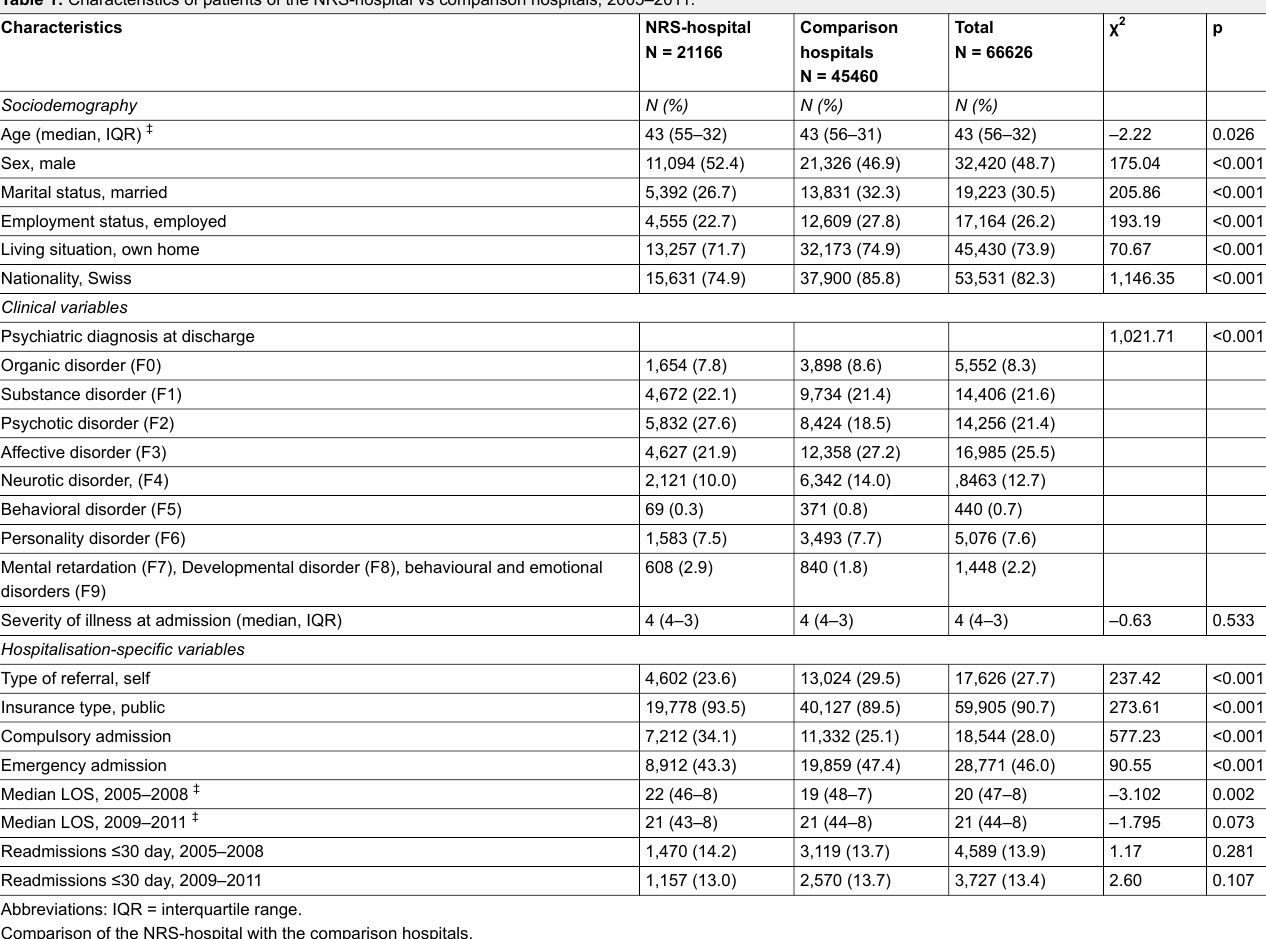
Table 1: Characteristics of patients of the NRS-hospital vs comparison hospitals, 2005–2011.